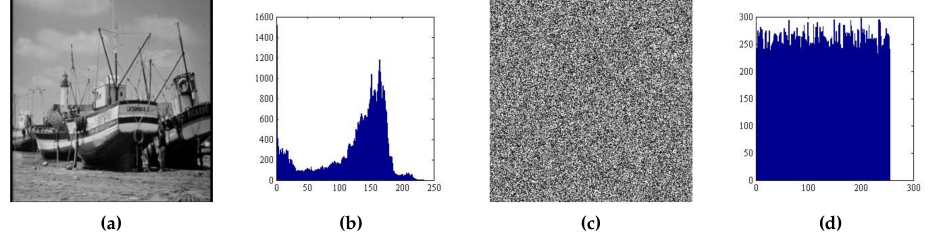
Figure 13. Result of Boats image. ( a ) Boats image, ( b ) histogram of Boats image, ( c ) encrypted Boats, and ( d ) histogram of encrypted